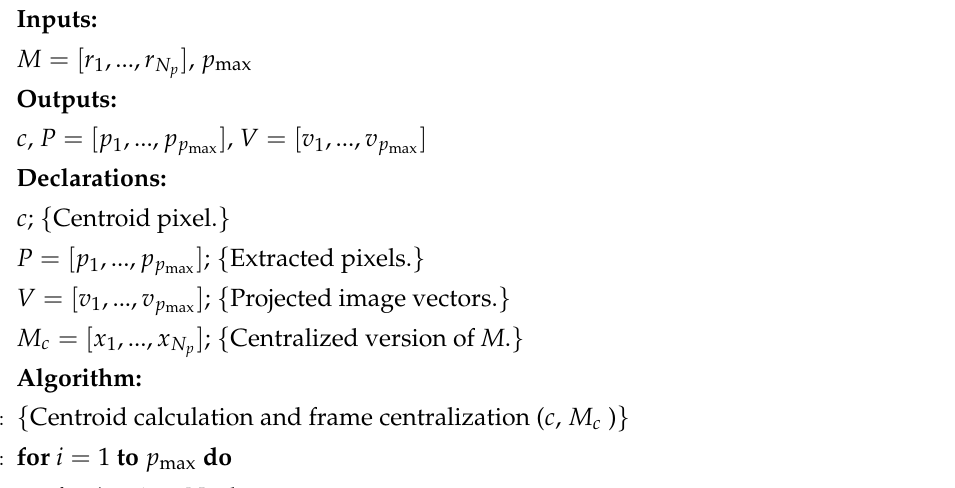
Algorithm 1 HyperLCA